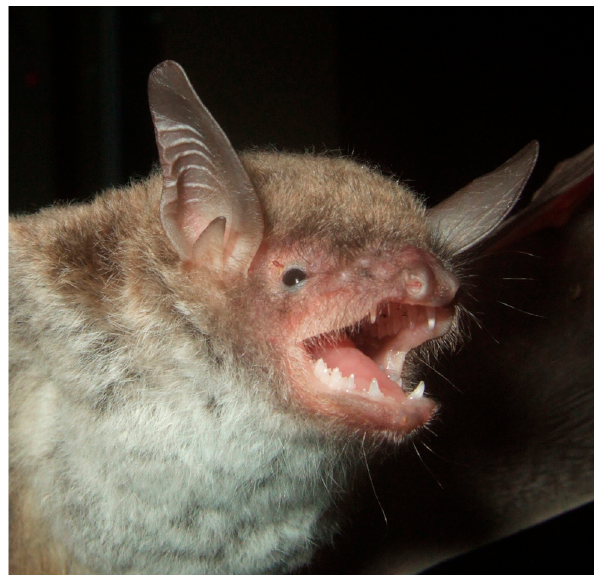
Figure 20. Myotis pilosus , adult male. Photograph by Vu Dinh Thong.